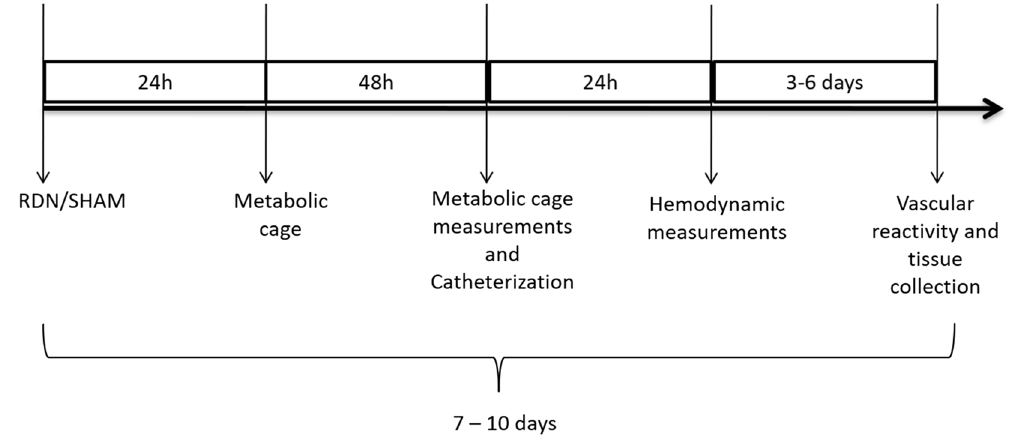
Figure 7. Schematic timeline protocol. RDN = renal denervation; h =